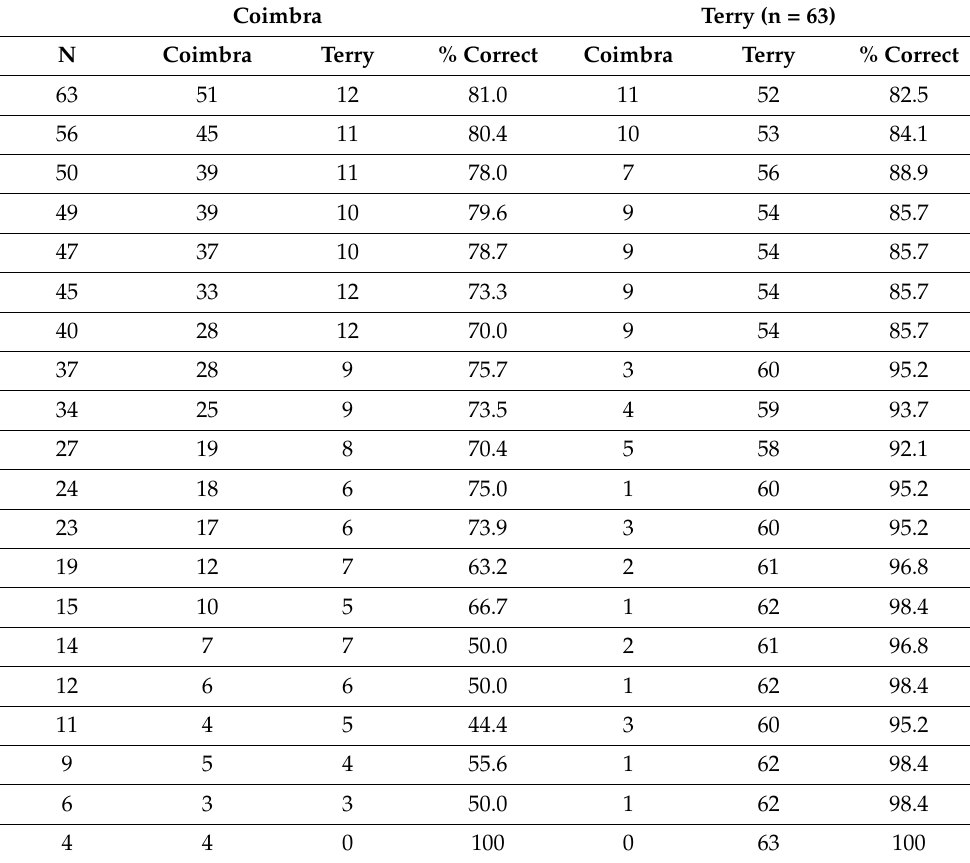
Table 4. Allocation accuracies using logistic regression with decreasing sample sizes from the Coimbra collection used to model mass grave scenarios with individuals whose sex was documented as male. Sample size from the Terry collection was held constant (n = 63) as a reference